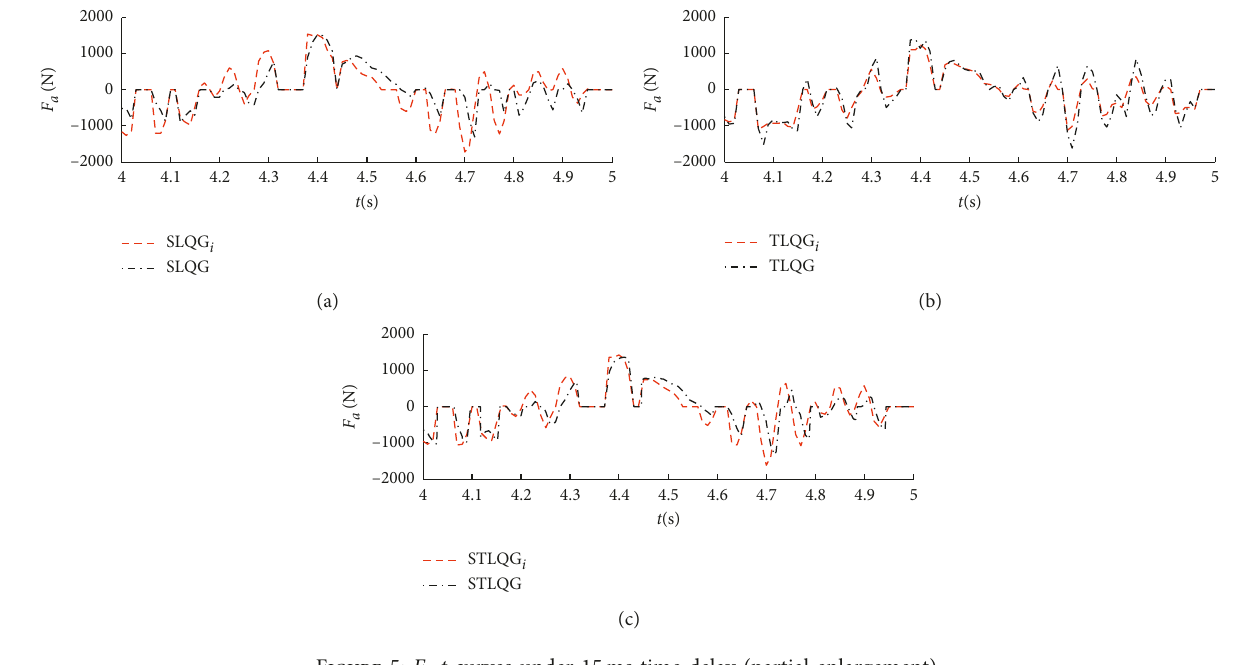
Figure 5: F a - t curves under 15ms time delay (partial enlargement).